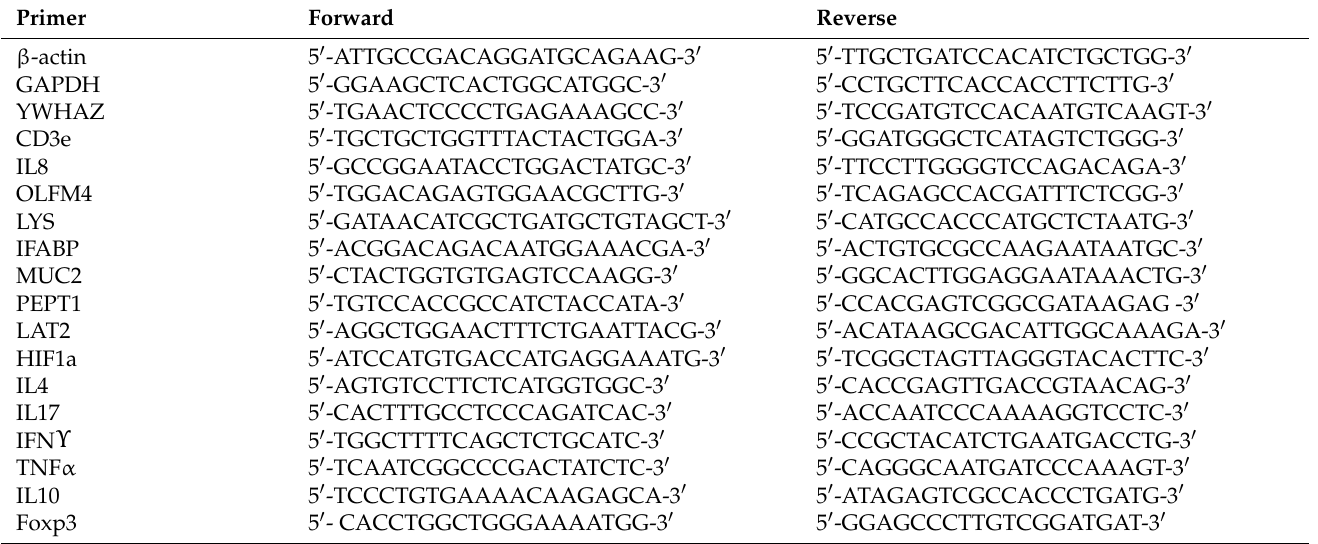
Table 1. Primer sequences.